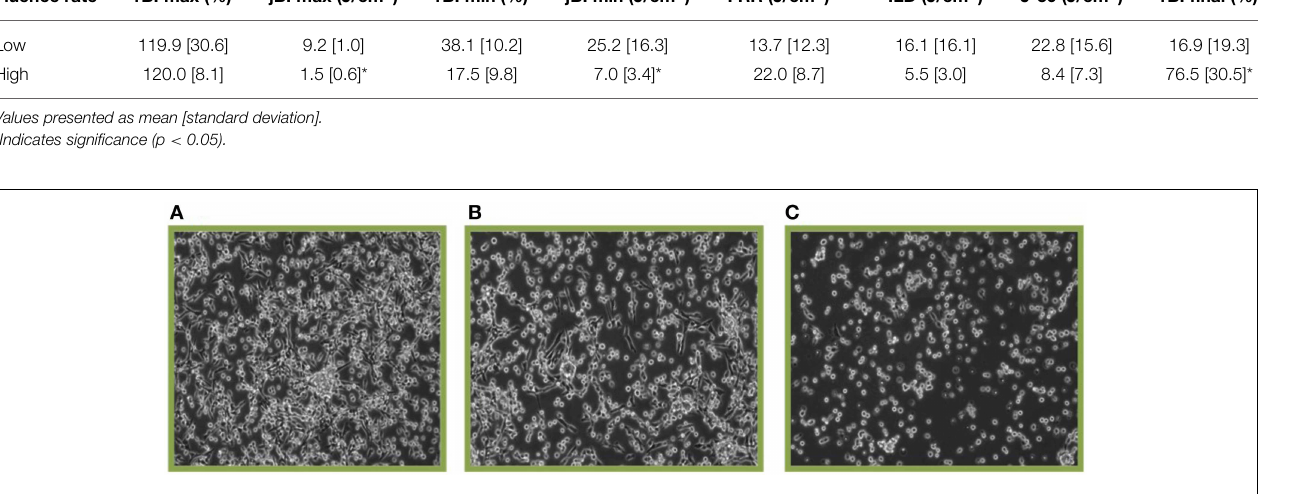
TABLE 2 | Summary of the blood flow variables for each fluence rate group. Fluence rate